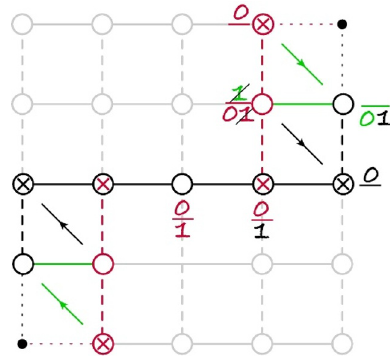
Figure 5 . Duality transformations from the alternating grading to the Beauty diagram: red to green to